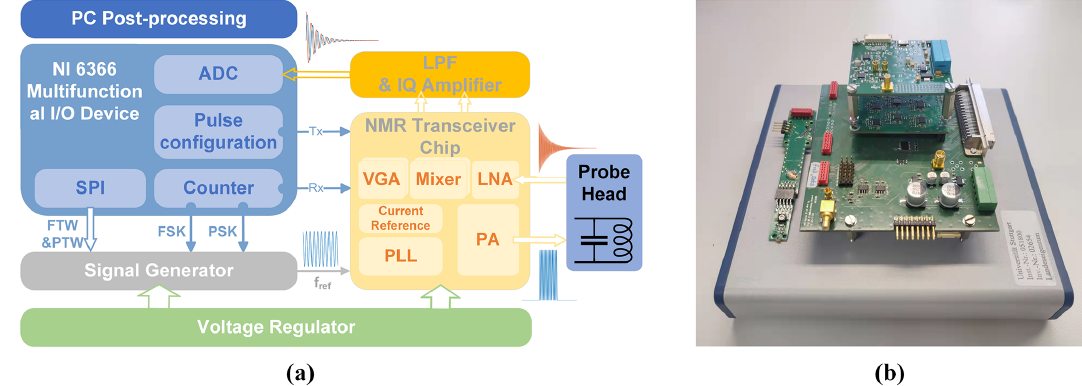
Figure 2. (a) Block diagram and (b) photograph of all electronics of the presented CMOS-based NMR platform.